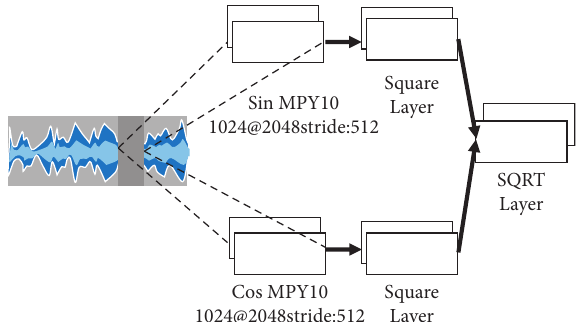
Figure 2: Network structure to compute the spectrogram layer [14].